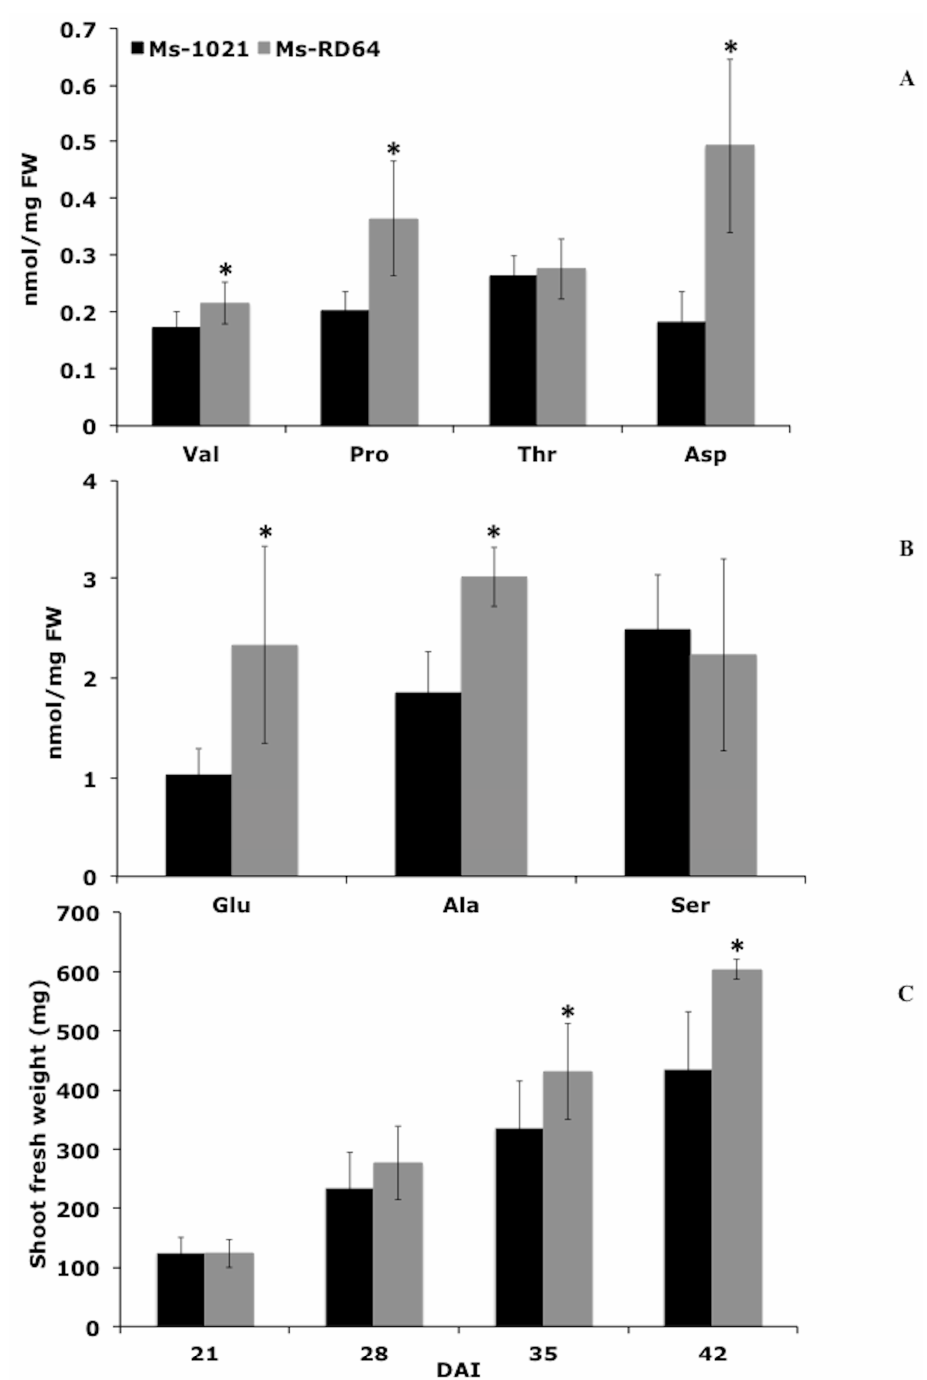
Figure 4. The inoculation of Medicago plants with the IAA-overproducing Ensifer meliloti RD64 increases the biosynthesis of nitrogen-rich amino acids and promotes plant growth. ( A ) Valine (Val), proline (Pro), threonine (Thr), and aspartic (Asp) content. ( B ) Glutamic (Glu), alanine (Ala), and serine (Ser) content. Data presented are the mean ± SD of seven biological replicates. ( C ) Shoot fresh weight of nodulated Medicago plants measured at 21, 28, 35, and 42 days after infection (DAI). Data presented are the mean ± SD of thirty biological replicates. The asterisks in all the panels indicate significant differences ( P < 0.05, one-way ANOVA with Tukey’s post-hoc test) between 1021- and RD64-nodulated plants.